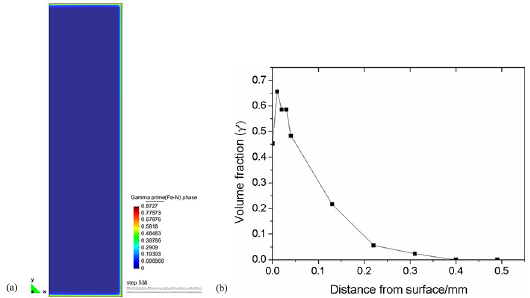
Figure 5. Simulated γ’ iron nitride results by COSMAP.